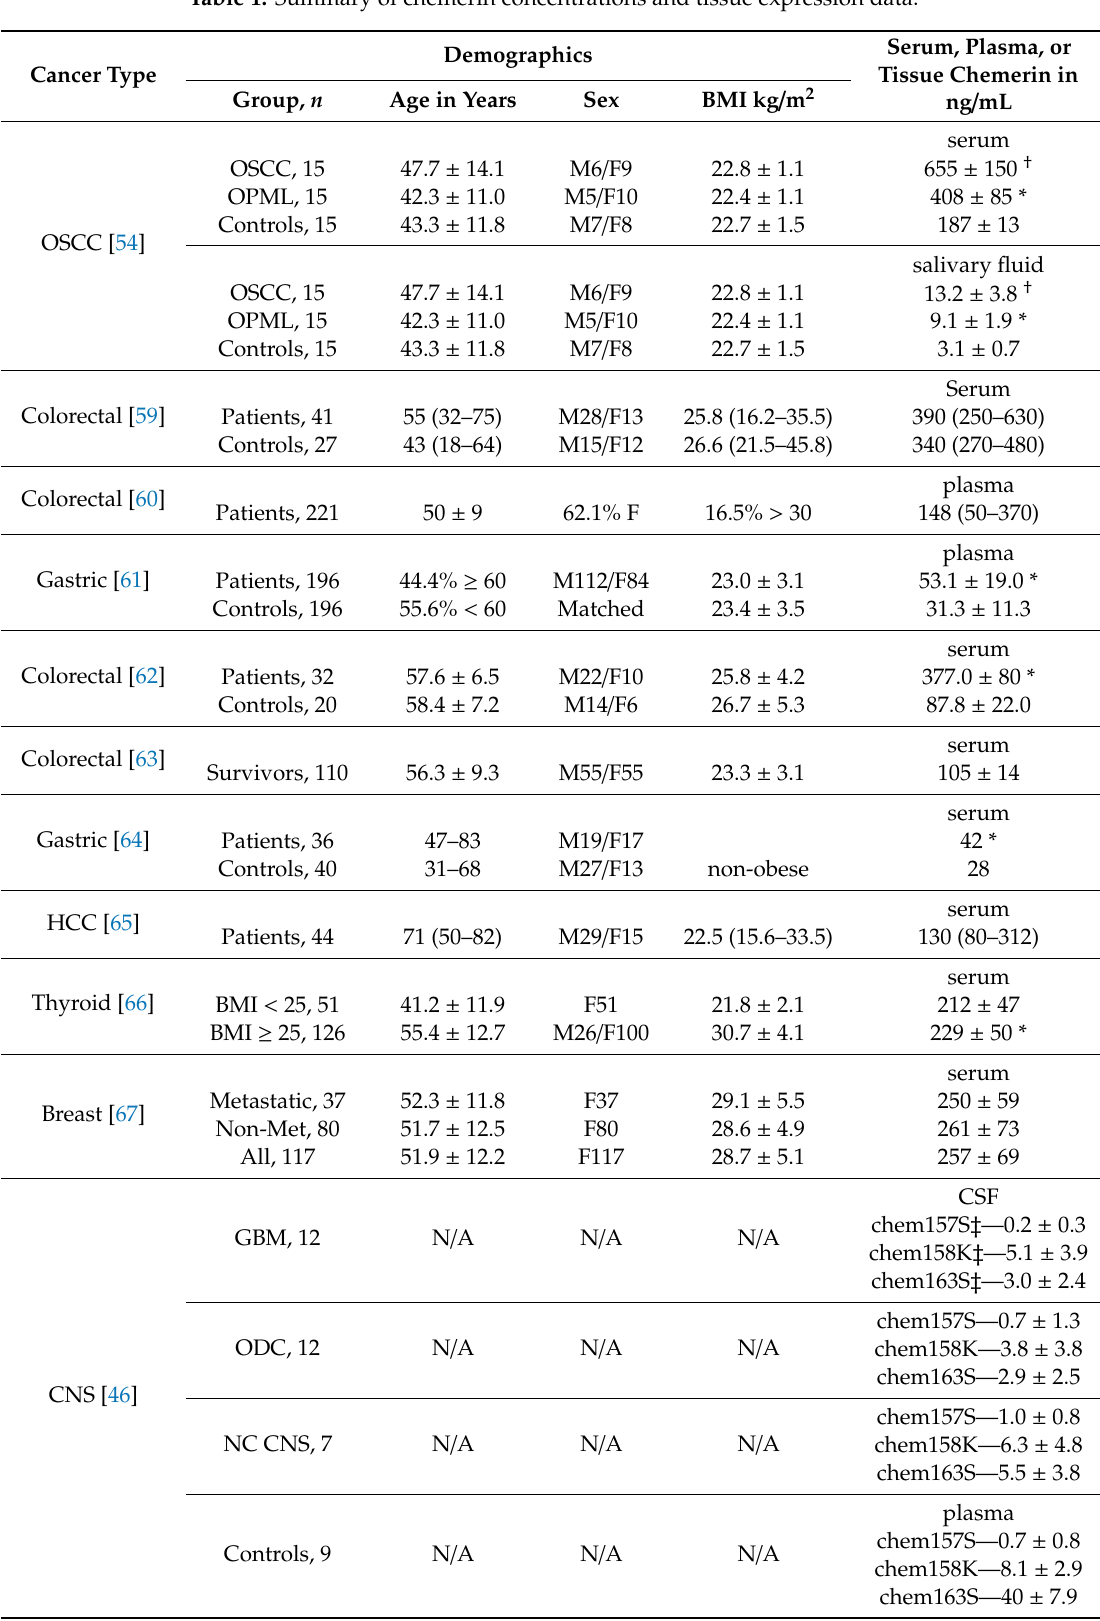
Table 1. Summary of chemerin concentrations and tissue expression